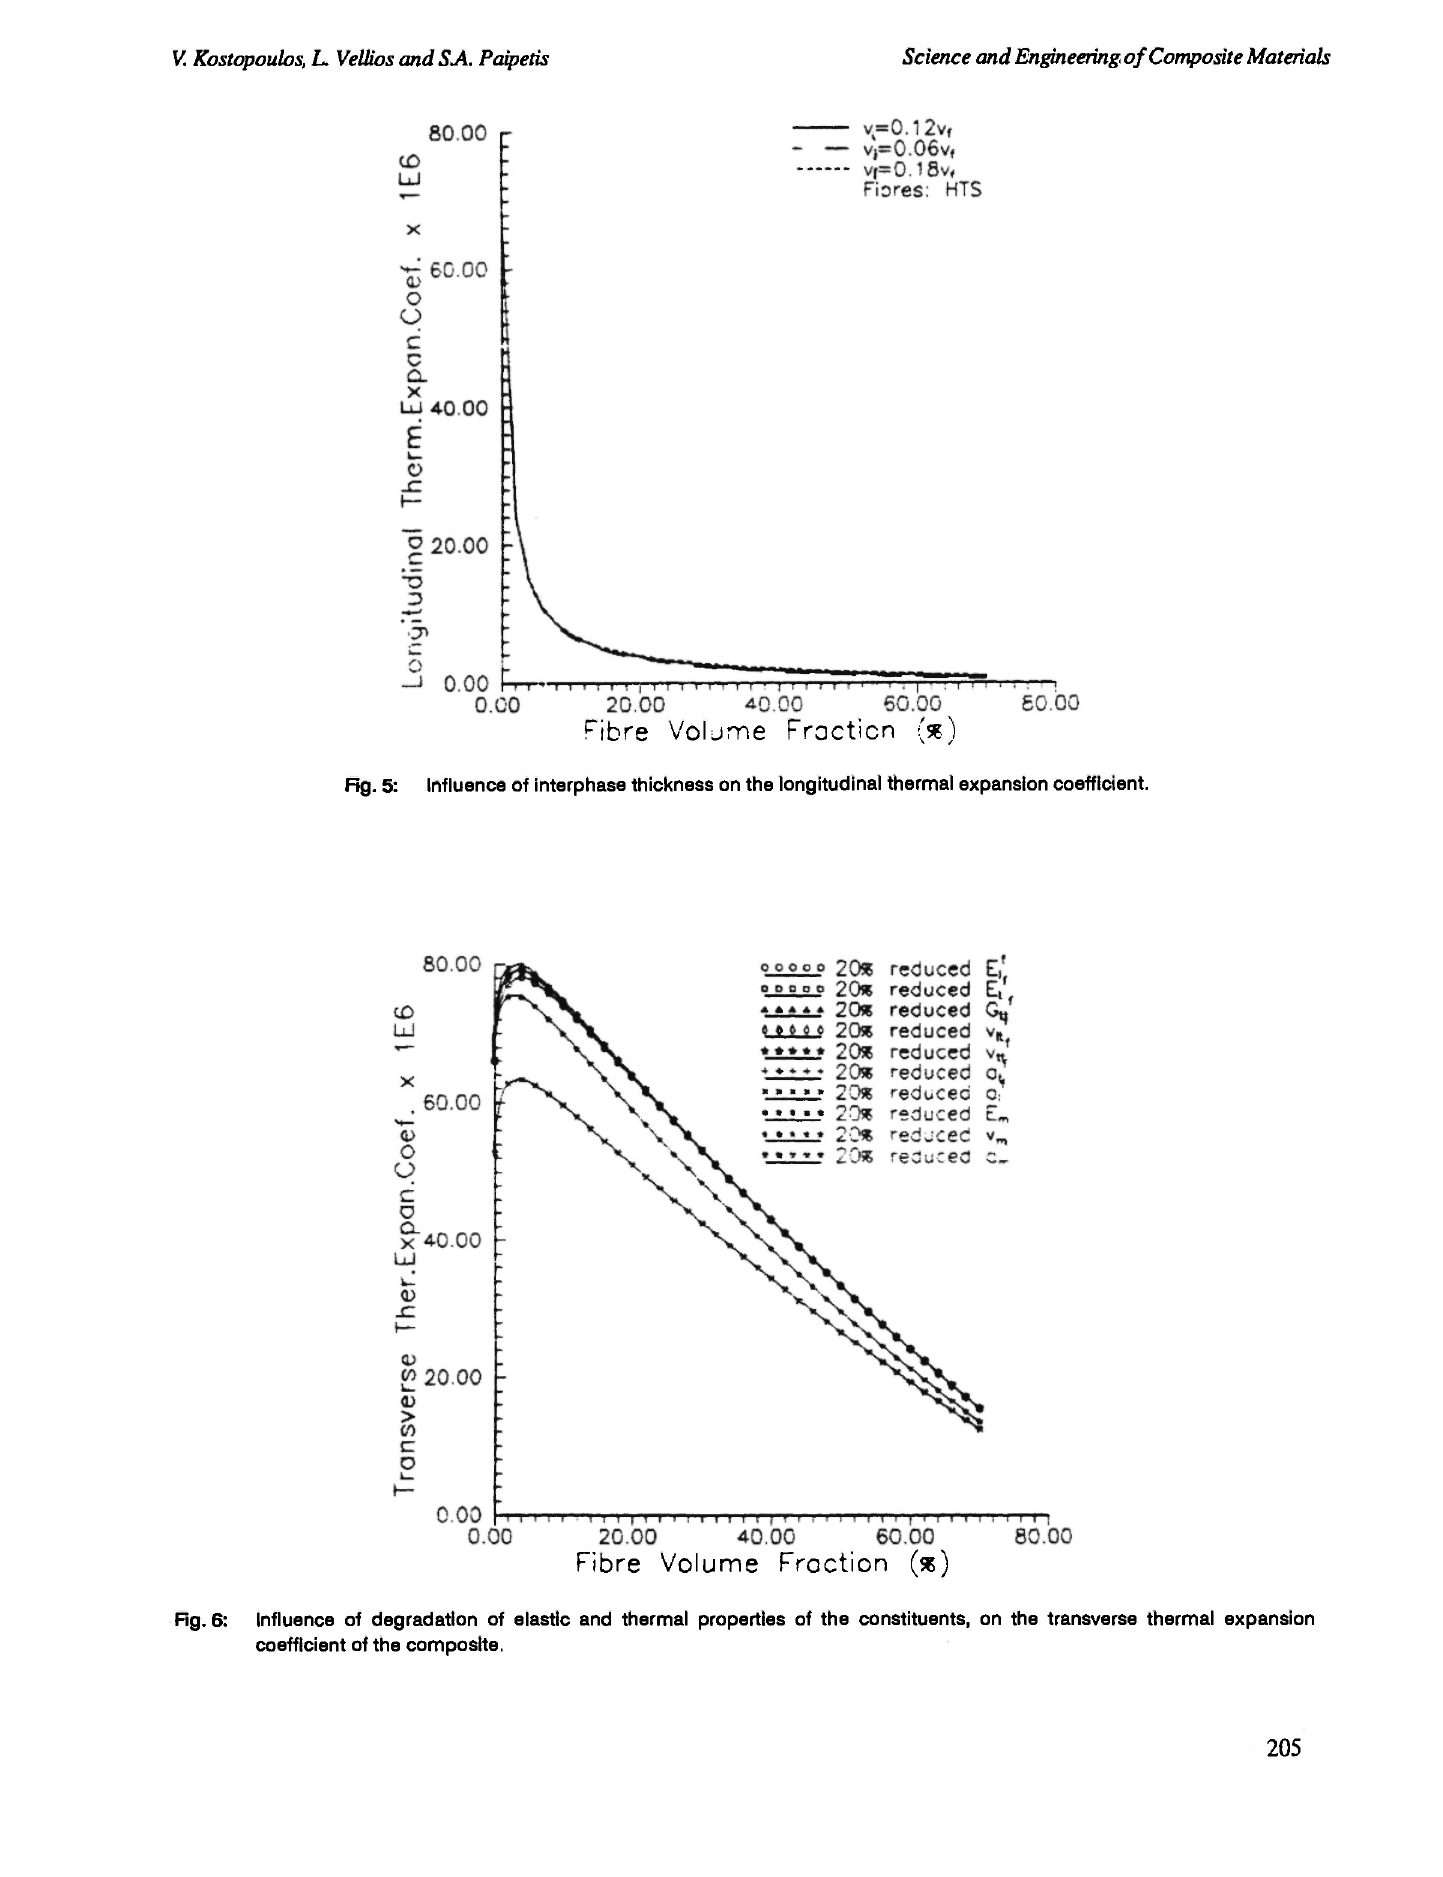
Fig. 6: Influence of degradation of elastic and thermal properties of the constituents, on the transverse thermal expansion coefficient of the